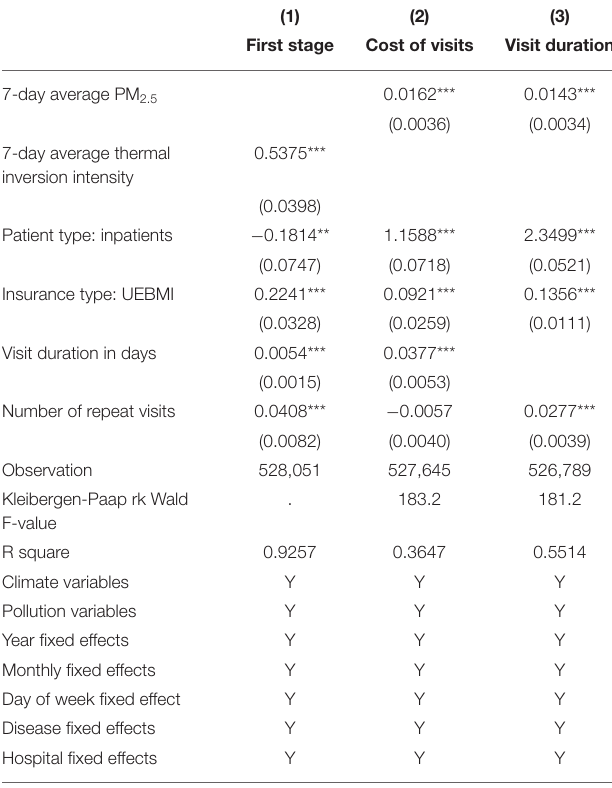
TABLE 3 | Impact of air pollution on the cost of visits and visit duration in days under